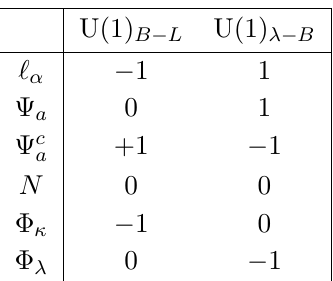
Table 3 . Charge assignments of ‘ (cid:11) ; (cid:9) a ; (cid:9) c ; (cid:8) (cid:20) ; (cid:8) (cid:21) under the two global symmetries of the fully- a symmetric model . The former coincides with the baryon minus lepton number of the SM particles. Besides the lepton doublet ‘ (cid:11) , we do not show the charges of the rest of SM particles. In the gauge model presented in appendix E, U(1) B (cid:0) L is a gauge symmetry while U(1) (cid:21) (cid:0) B remains an accidental global symmetry. Under U(1) (cid:21) (cid:0) B , the rest of SM particles carry the charges same as U(1) L (cid:0) B . On the other hand, the two symmetries are absent in the non-symmetric model originated from warped extra dimension since (cid:8) (cid:20);(cid:21) , which are identi(cid:12)ed with the dilaton, are